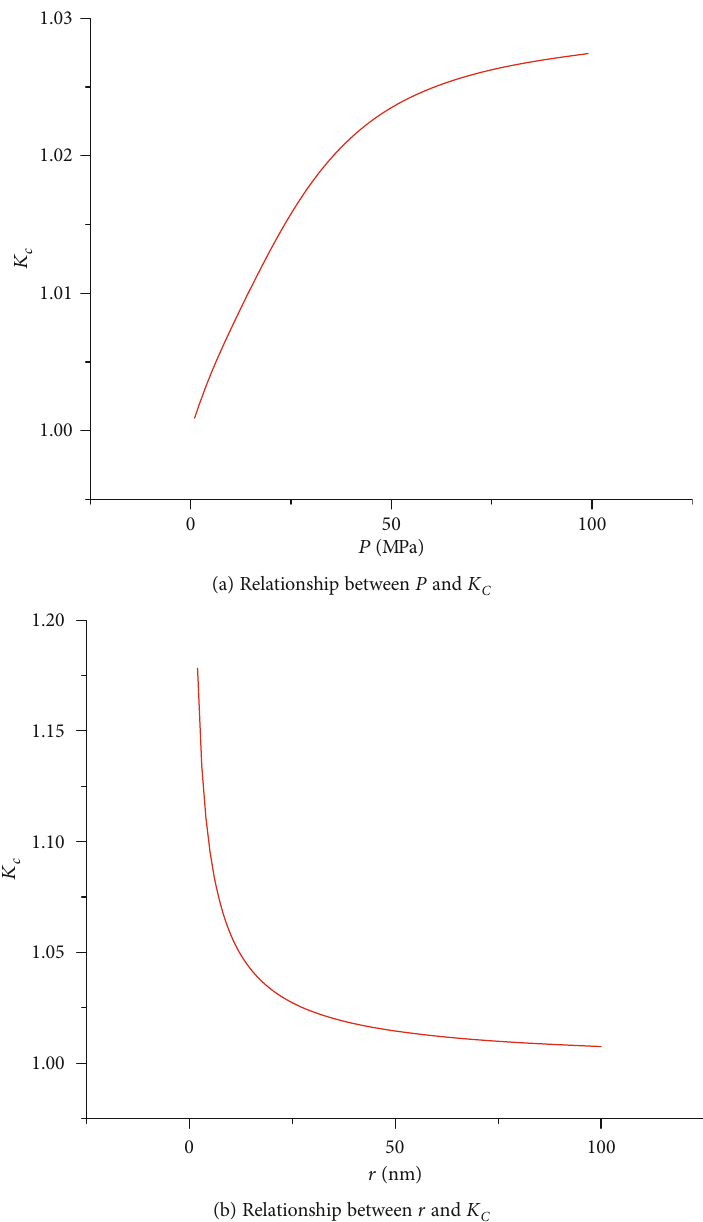
Figure 6: E ff ect of the miscible zone and high-viscosity fl owing water fi lm on gas transport capacity. (a) T = 300 K, h θ = 30 ° , r = 4 nm ; (b) T = 300 K, h 0